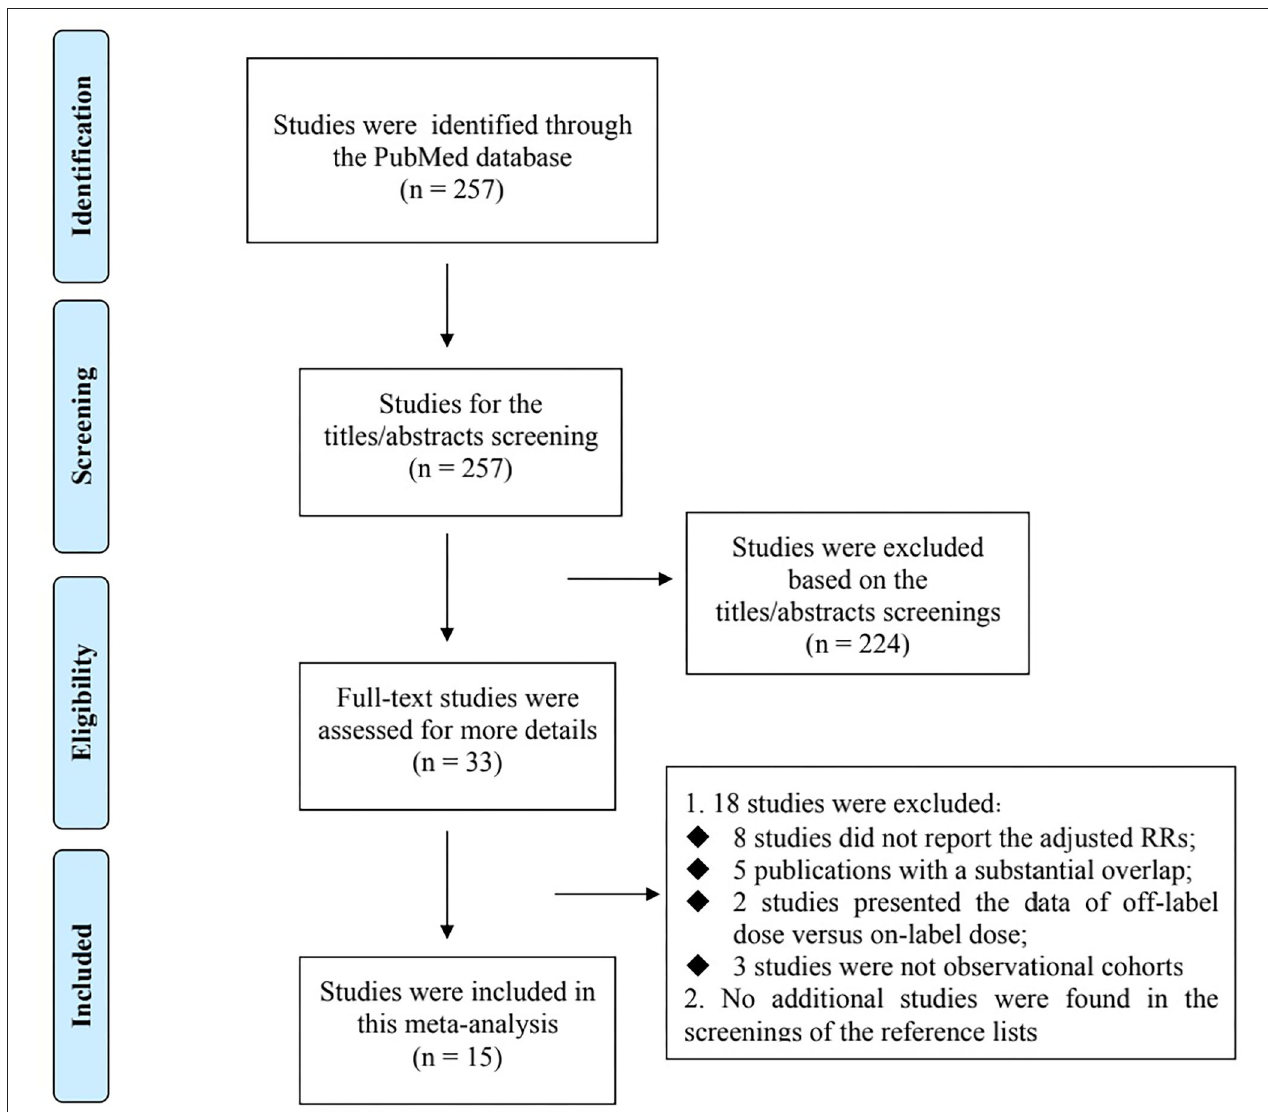
FIGURE 1 | Flowchart of electronic retrievals of this